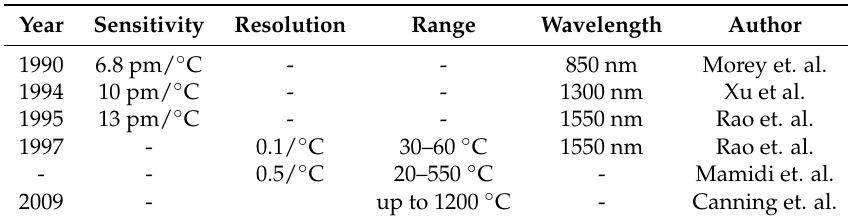
Table 1. Summary of Fiber Bragg Grating Temperature